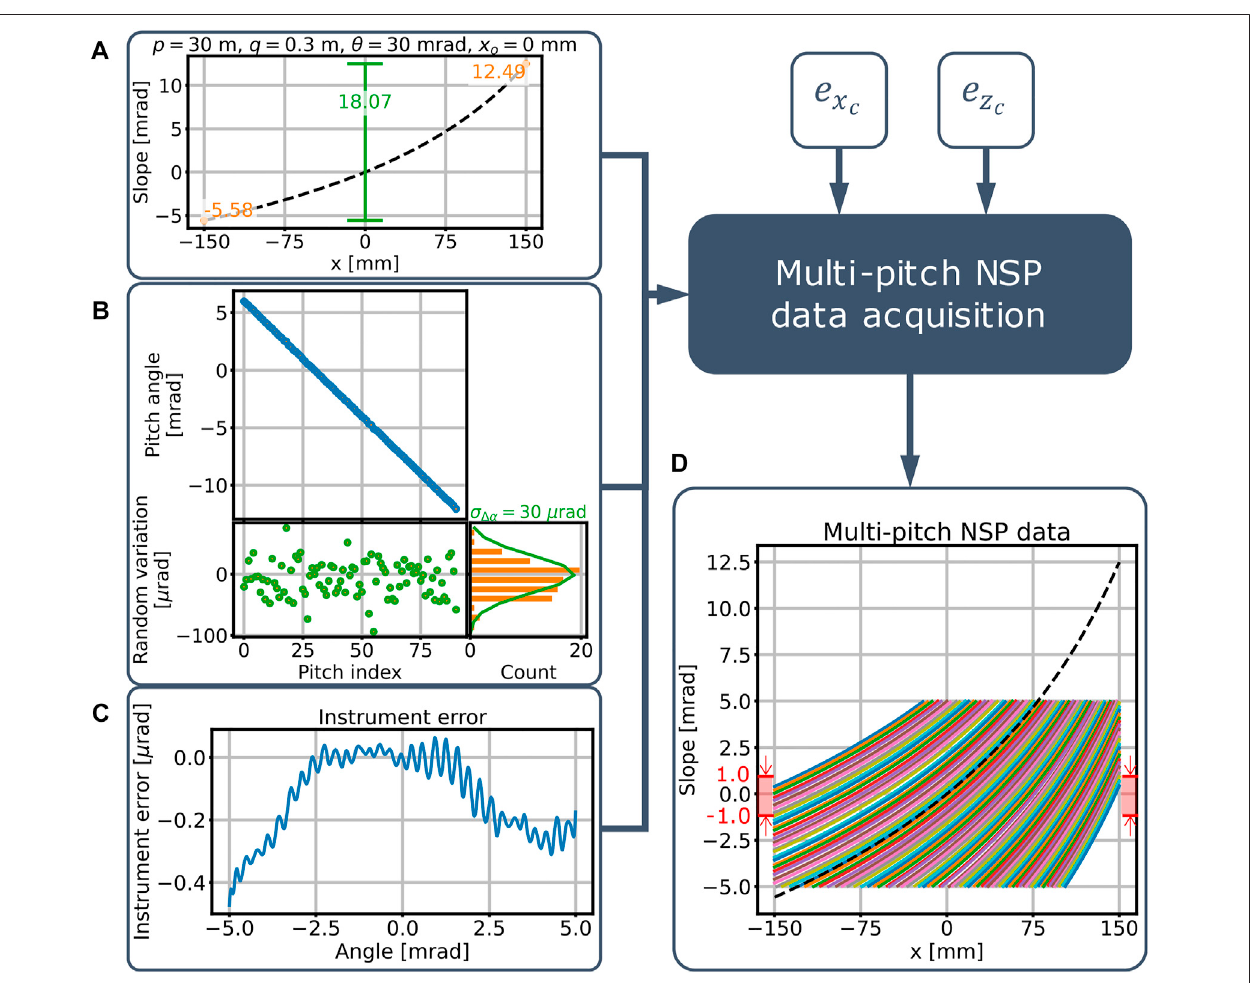
FIGURE 3 | The simulation of the multi-pitch NSP dataset. (A) the tangential slope of the elliptical cylinder with the default parameters, (B) the pitch angle and its randomvariationsinstep, (C) theinstrumenterrorofsample-beamautocollimatorfromarealmulti-pitchNSPmeasurement,and (D) thesimulatedmulti-pitchNSPdata with the dashed curve showing the whole slope pro fi le of the test